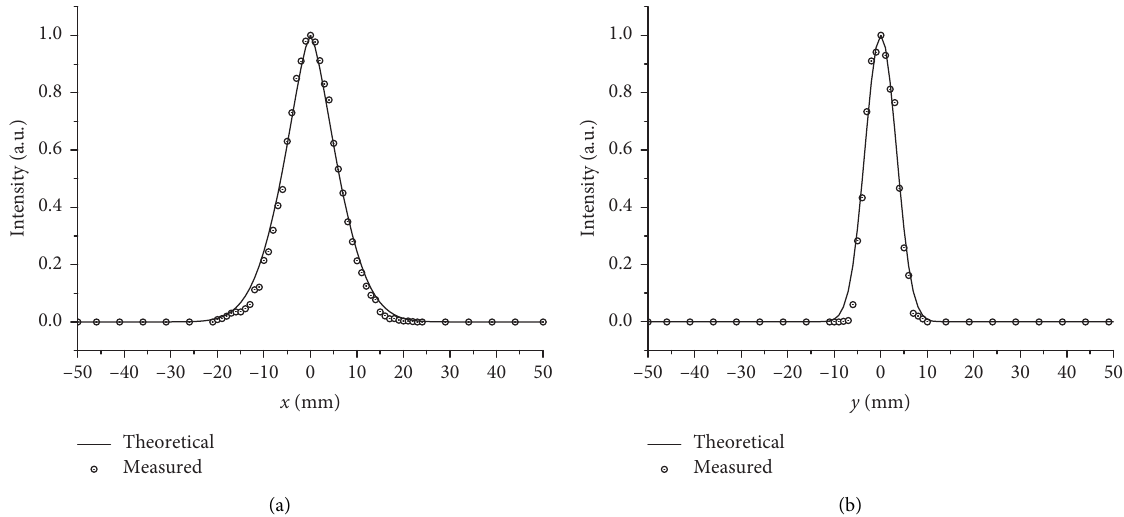
Figure 3: Measured and theoretical beam intensity profiles of HL63391DC. (a) x – z plane. (b) y – z